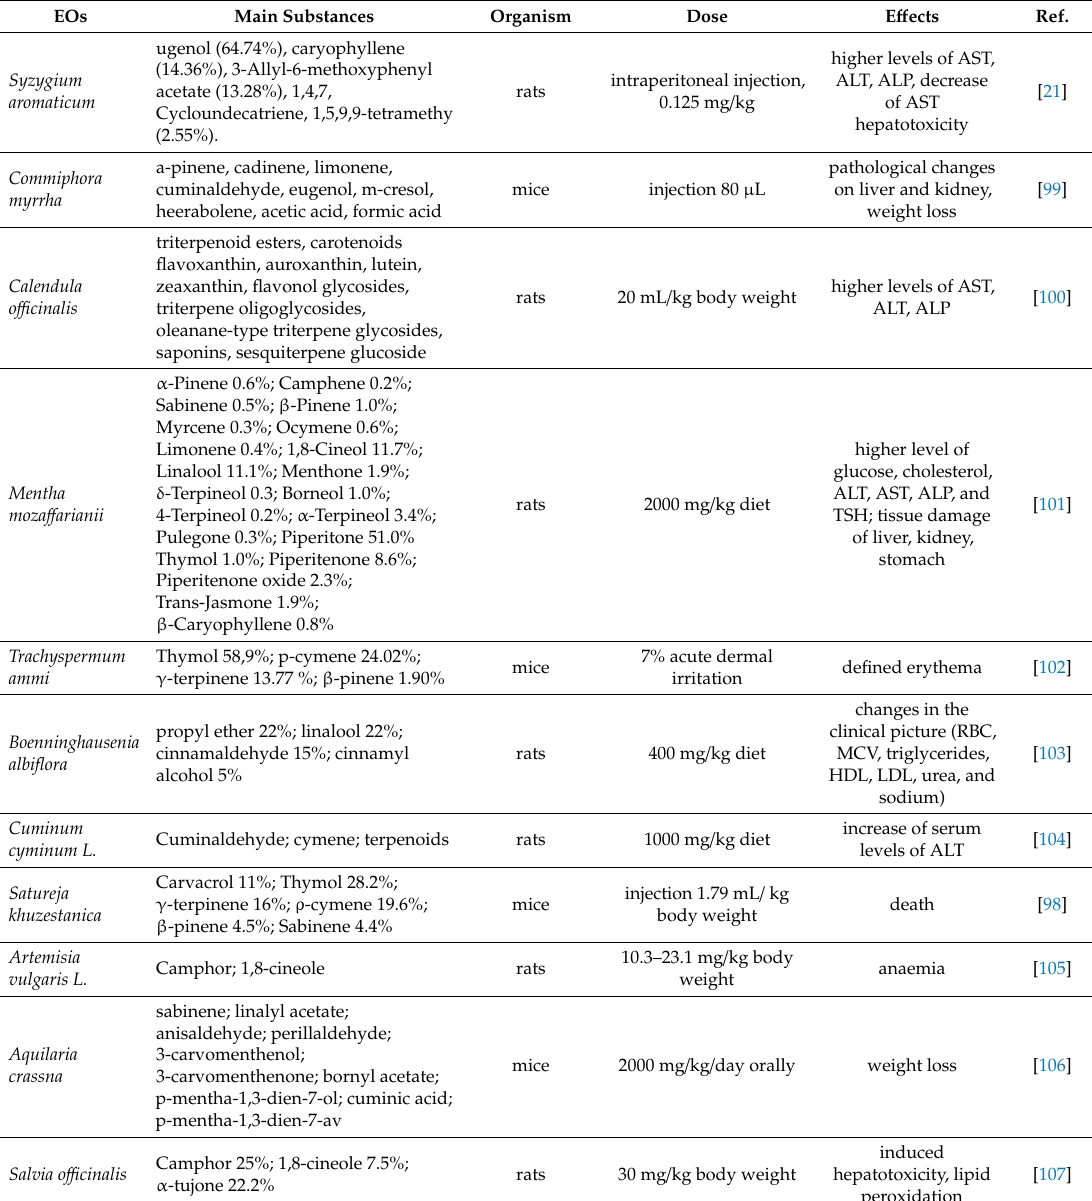
Table 2. Overview of the e ff ects of EOs tested in